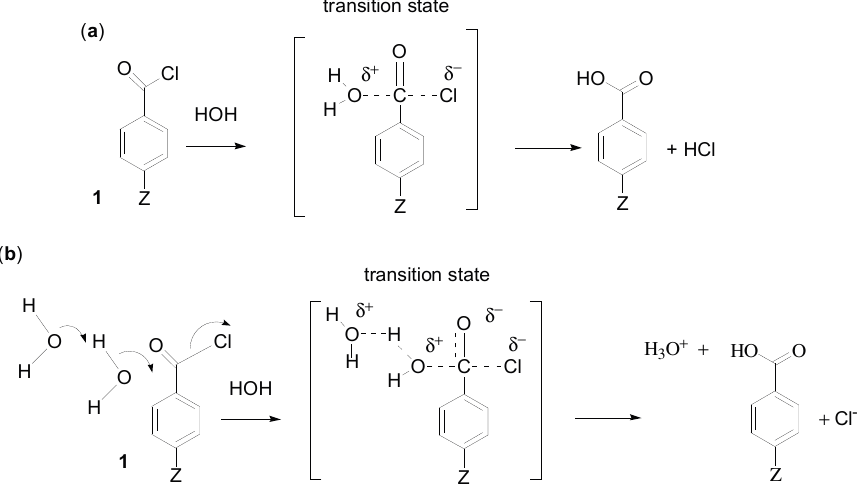
Figure 1. Possible reaction mechanisms for solvolyses of p -Z-substituted benzoyl chlorides ( 1 ): ( a ) The S N 1-S N 2 (cationic) reaction channel in which one or two molecules undergo covalency change to varying extents; ( b ) The S N 2-S N 3 third order (addition-elimination) reaction channel in which three molecules undergo covalency change to varying